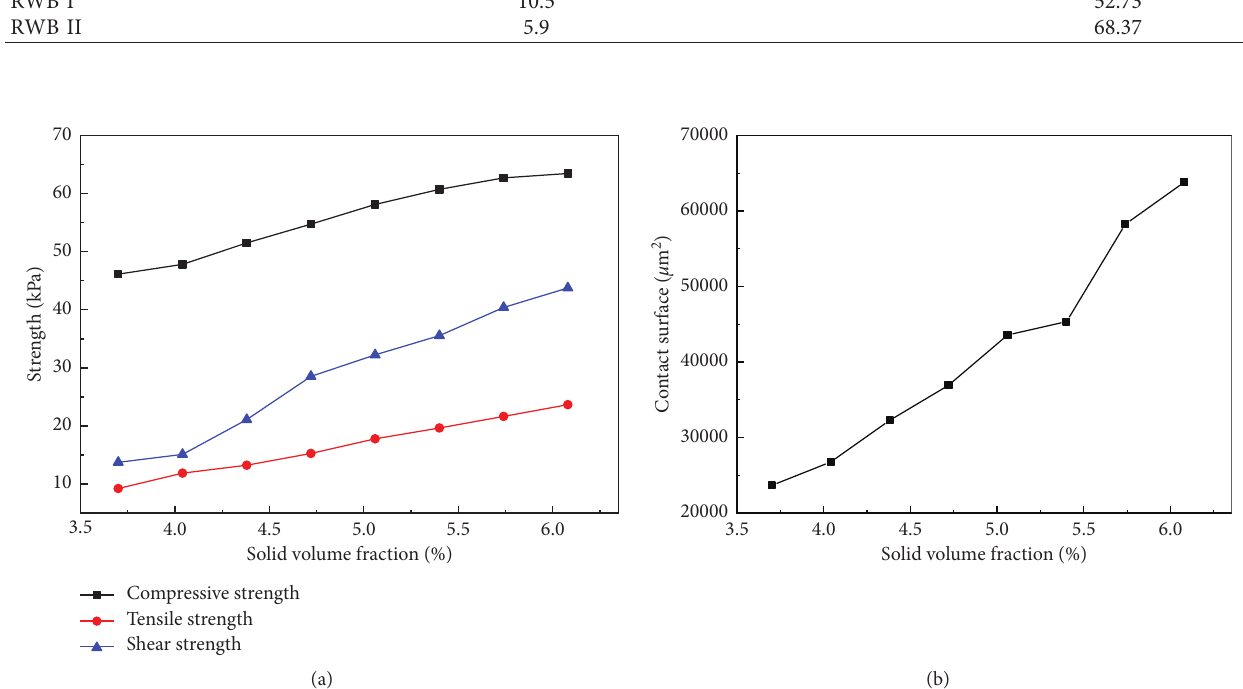
Figure 10: (a) Mechanical properties of RWB with different SVFs (mean diameter � 10.5 μ m); (b) relationship between the fiber contact area and SVF (mean diameter � 10.5 μ